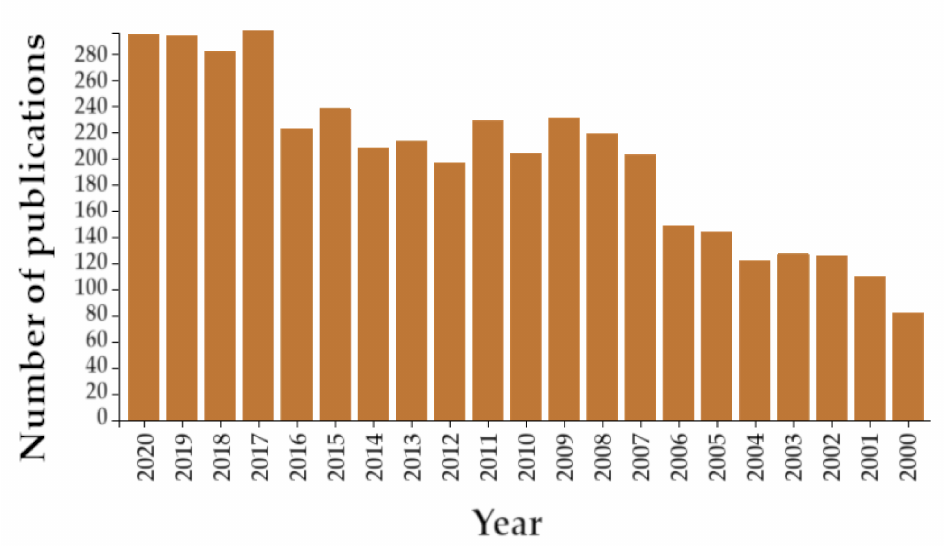
Figure 2. Number of publications per year based on www.webofscience.com (accessed on 21 June 2021) results analysis for the topics “catalytic methane combustion” or “catalytic methane oxidation” and “ventilation air methane” taken 21 June